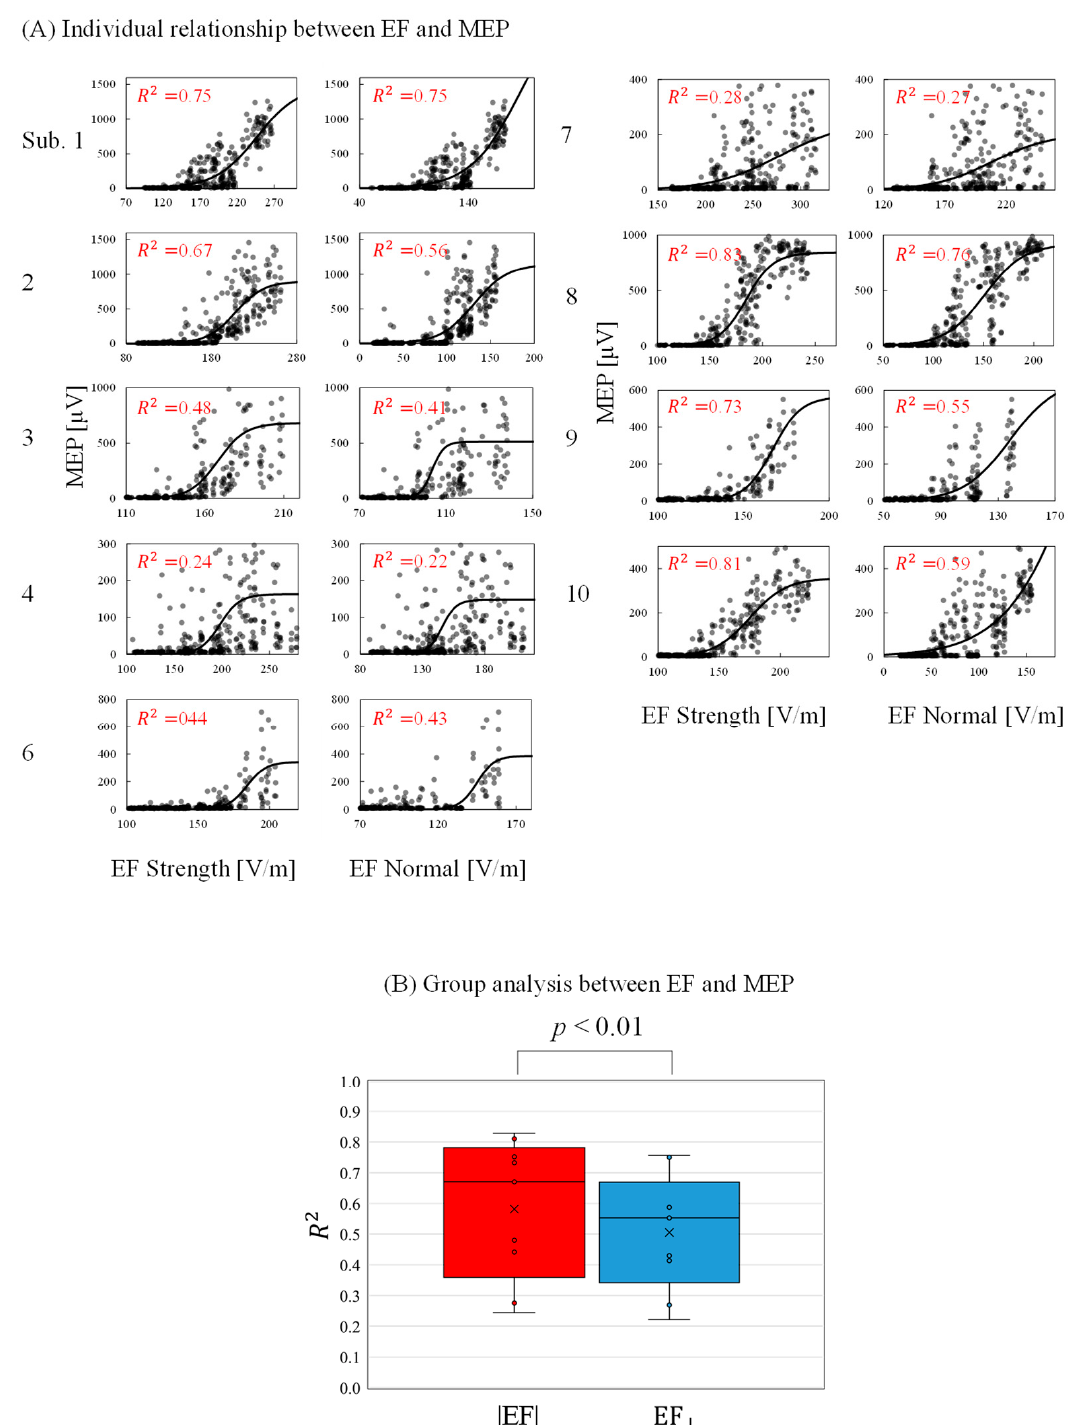
Figure 6. ( A ) Relationship between individual induced electric field (EF) metrics (EF strength and EF normal component) and motor-evoked potentials (MEPs) at the estimated cortical region location (coefficient of determination [ R 2 ] with p < 0.01 in each graph). ( B ) Grand average of the coefficient of determination ( R 2 ) between EFs and MEPs.